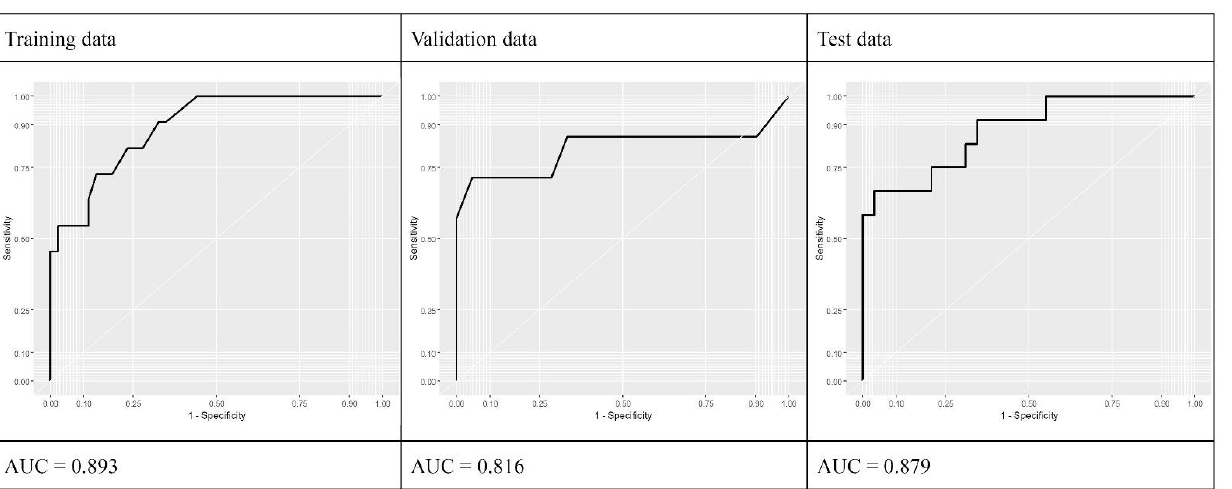
Figure 2. ROC analysis for predicting LECS requirement during endoscopic resection.